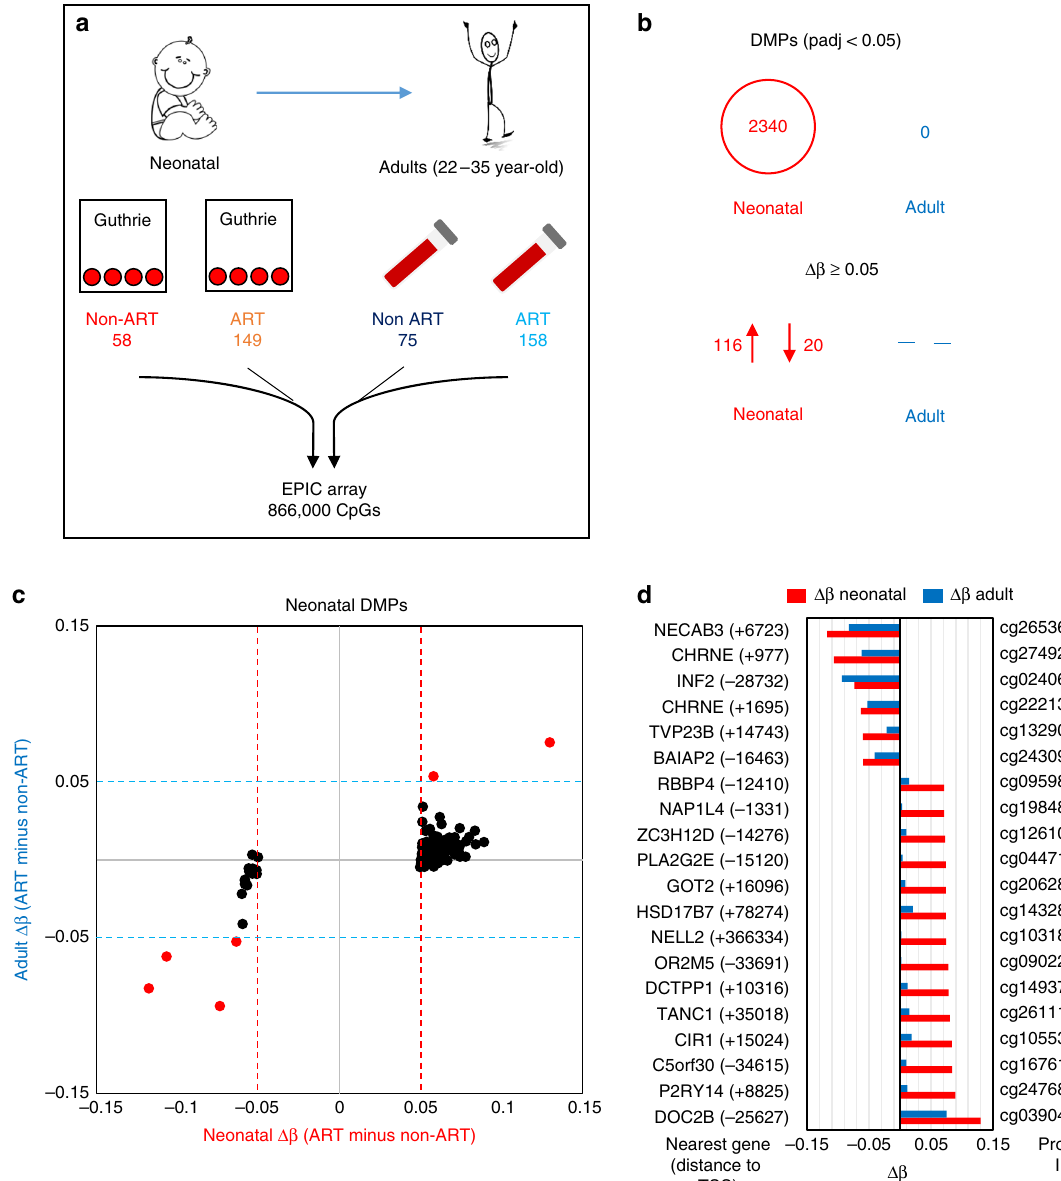
Fig. 1 Study design and identi fi cation of ART-associated differentially methylated probes in neonatal and adult blood. a Summary of the longitudinal EWAS. b Number of DMPs that pass an adjusted p -value cut-off of <0.05 and a Δβ cut-off of ≥ 0.05. c Correlation plot of mean Δβ between ART and non-ART groups in neonatal ( x axis) and adult ( y axis) blood at neonatal DMPs. Δβ is always calculated as mean ART DNA methylation minus mean non-ART DNA methylation. Red dots represent probes that show a Δβ ≥ 5% between ART and controls in both neonatal and adult blood (red dotted line and blue dotted line designate the 0.05 mark in all directions), black dots represent probes that only ful fi ll DMP criteria at birth. d . Bar plot of neonatal (red) and adult (blue) blood Δβ values for top ranked probes based on methylation change in neonatal blood, with accompanying probe ID, name of nearest gene and distance to gene TSS in brackets. While most probes no longer show differences in adult blood (at adjusted p -value <0.05 (Bayesian levene ’ s test)), there are several probes that show a persistent change in methylation. n = 207 biologically independent birth samples, n = 233 biologically independent